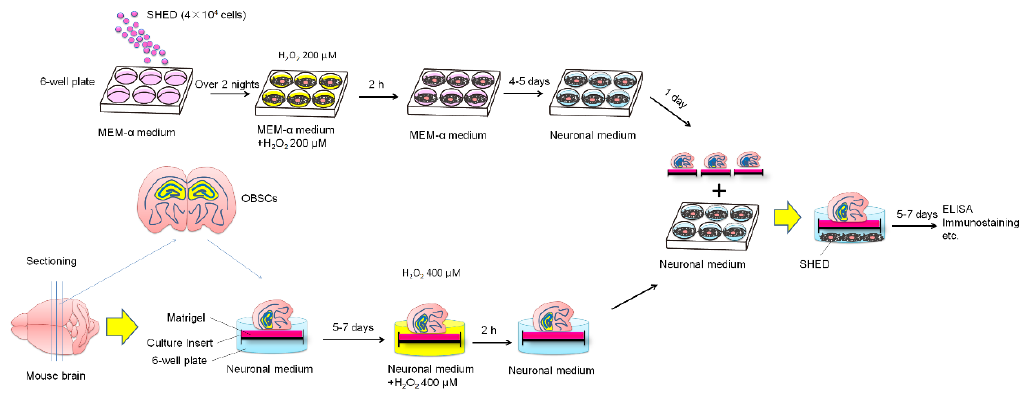
Figure 1. Experimental setup and cultivation schedule.